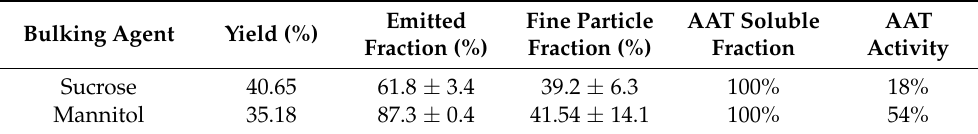
Table 4. Characteristics of powders prepared from 50 mL solutions of rAAT with L-leucine and sucrose or mannitol as bulking agents.